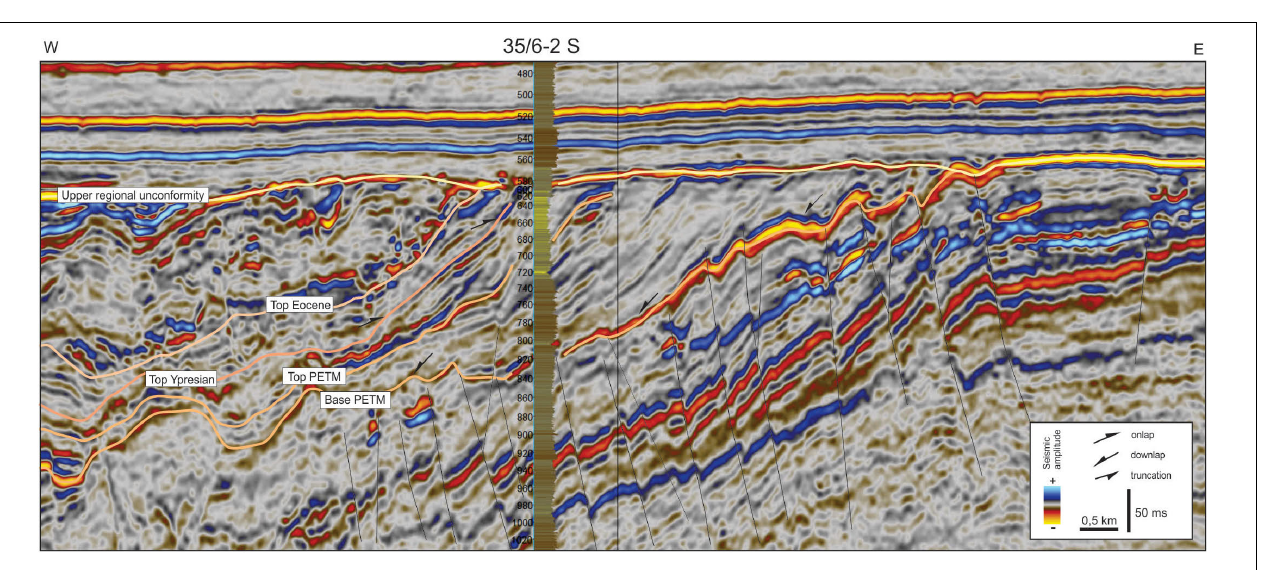
FIGURE 5 | Dip-line of the PETM succession through borehole 35/6-2S. The onset of the PETM is marked by a distinct downlap surface indicating a minor relative sea-level rise and reorganization of the feeder system. The underlying Thanetian succession was remobilized and locally faulted just prior to PETM progradation, controlling the thickness and distribution of PETM strata. The end of the PETM interval is not marked by distinct stratal relationships and progradation continued during deposition of the early Ypresian Balder Fm above 680 m. See Figure 2 for location on regional